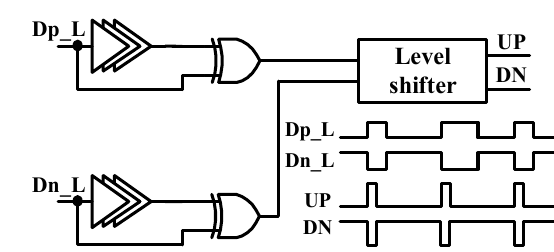
Figure 7. The architecture of the output driver.